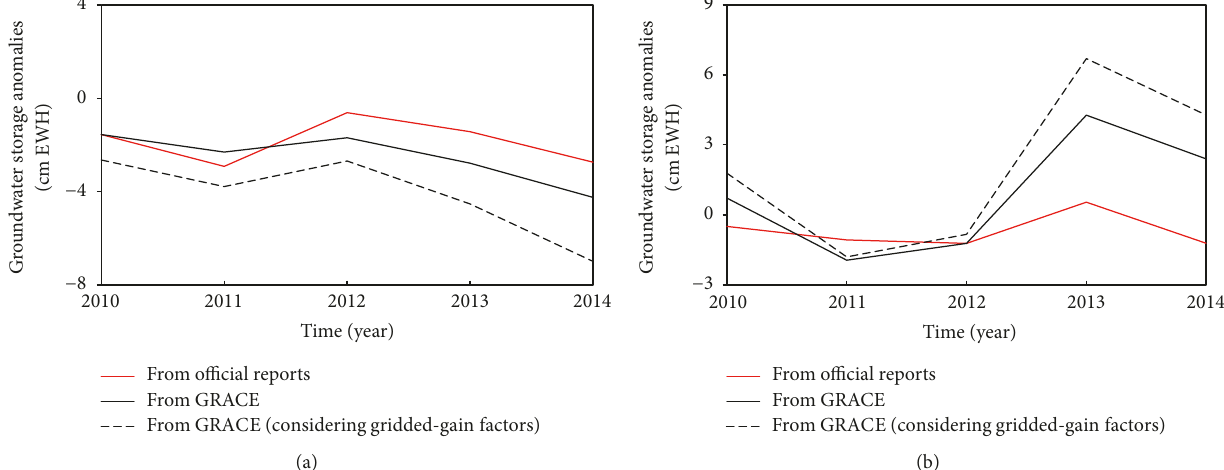
Figure 7: Comparison of the annual measured and derived GWS variations in (a) the Huang-Huai-Hai Plain and (b) the Song-Liao